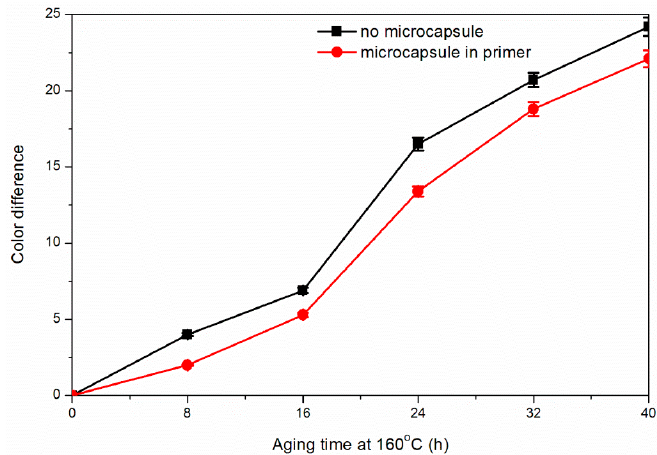
Figure 7. E ff ect of aging time on color di ff erence of the paint film in the 160 ◦ C oven. Figure 7. Effect of aging time on color difference of the paint film in the 160 °C oven.